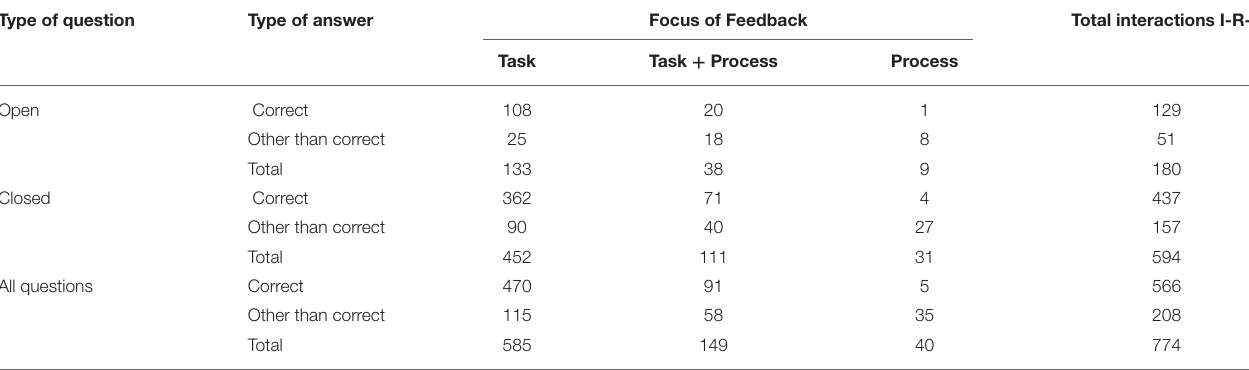
TABLE 8 | Frequency of the focus of feedback according to type of question and type of answer in I-R-F interactions. Type of question